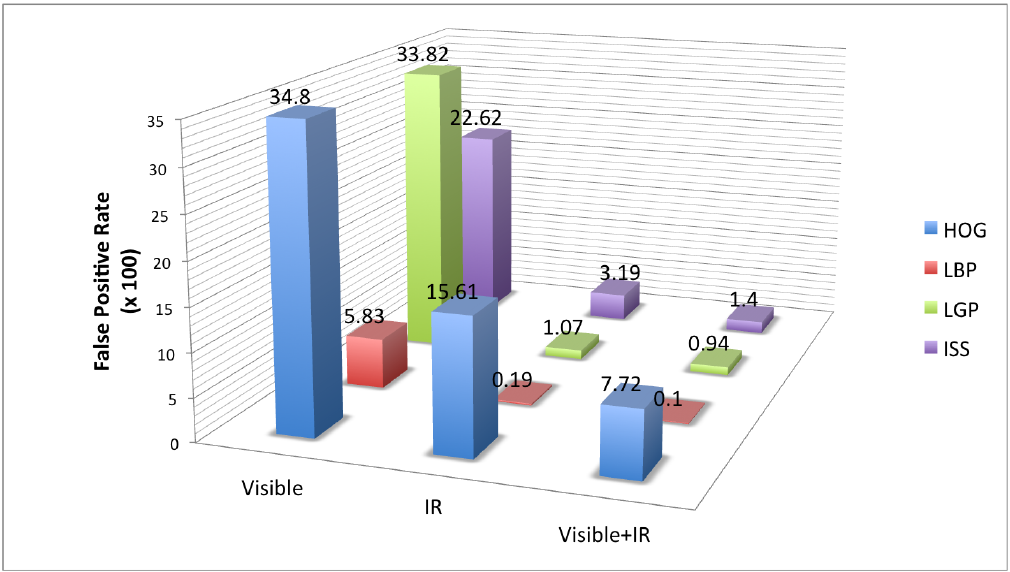
Figure 11. Results overview of the RIFIR dataset.